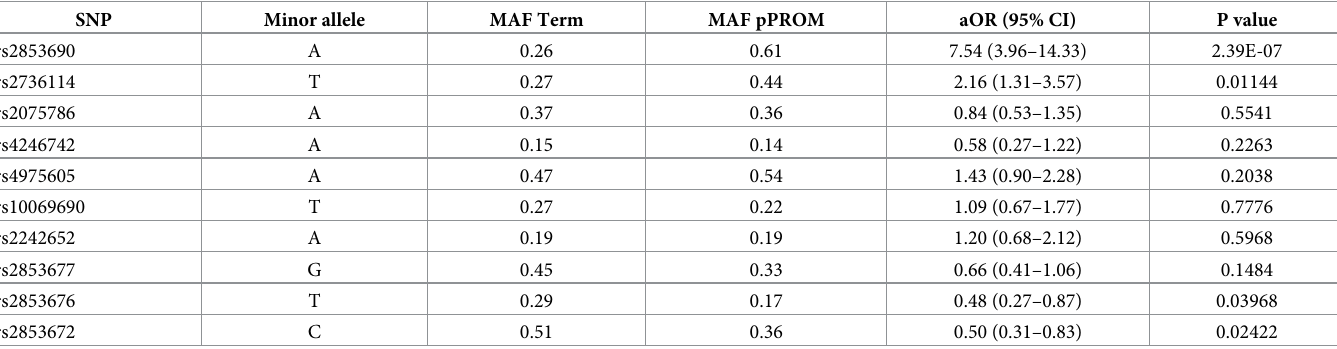
Table 5. Logistic regression results for maternal single locus allele frequencies among cases and controls and association with preterm premature rupture of membranes.